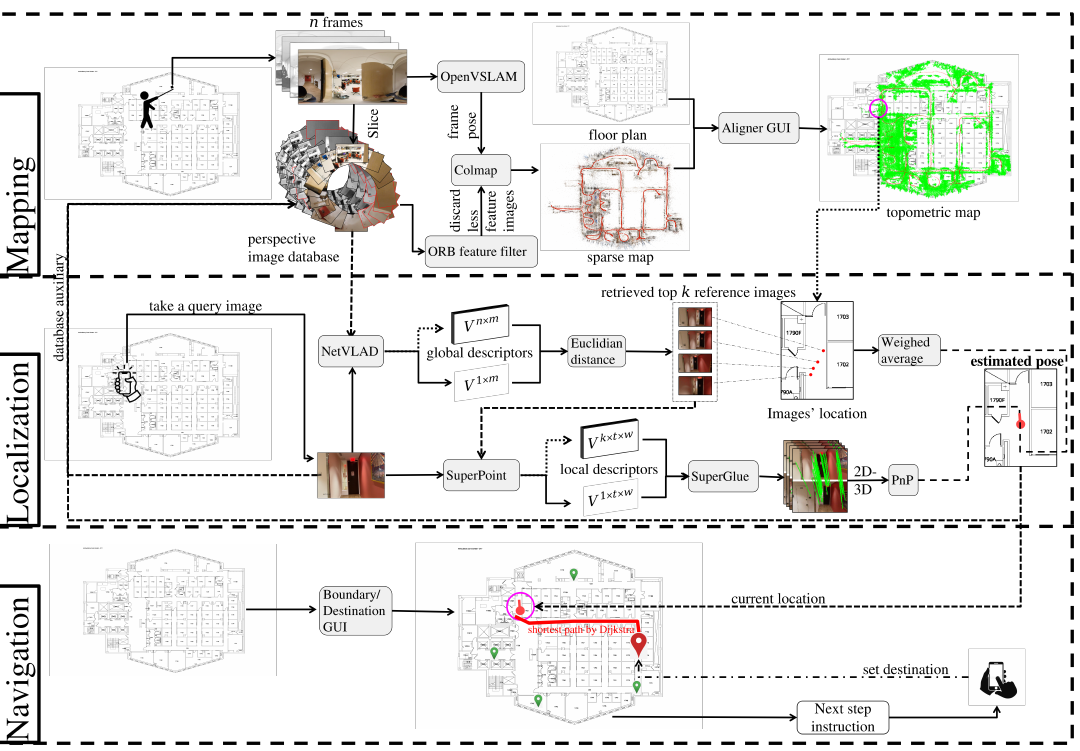
Figure 1. System architecture diagram. Our pipeline consists of mapping, localization, and naviga- tion modules. During the mapping module, OpenVSLAM and Colmap algorithms use 360-degree images as input to generate a topometric map. On the basis of this topometric map, NetVLAD will first retrieve images similar to a query images; this is followed by two downstream tasks: weight averaging and coarse-to-fine PnP algorithms, which estimate the location and direction of the query image. In the navigation module, Dijkstra’s algorithm computes the shortest path between any database images using a navigable graph defined by the topometric map’s boundaries. During real-time navigation, our system will utilize both the shortest-path information and predefined desti- nations to guide end users to their desired destination. The captured query image will be returned to the mapping module to aid in the evolution of the topometric